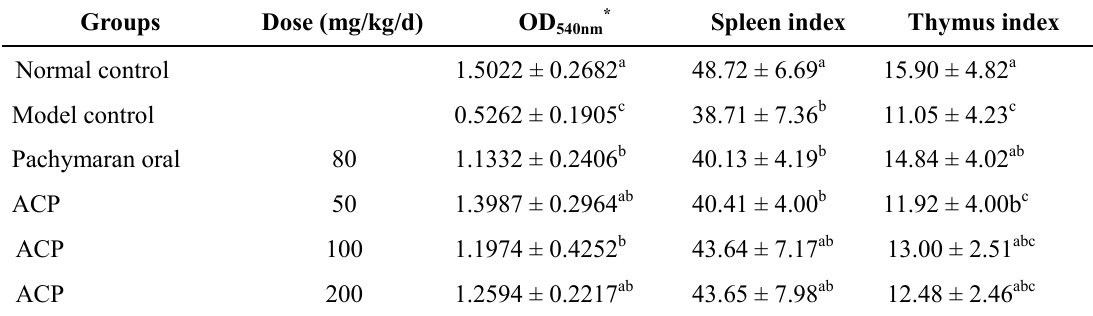
1.2594 ± 0.2217 ab 43.65 ± 7.98 ab 12.48 ± 2.46 abc Note: Results are represented as the means ±SD (n = 10) in each group and there are significant differences indicated by the different letters in the same column. Normal control and model control generation of serum hemolysin.